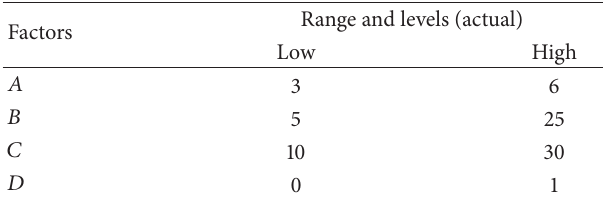
Table 2: Experimental range and levels of independent variables.